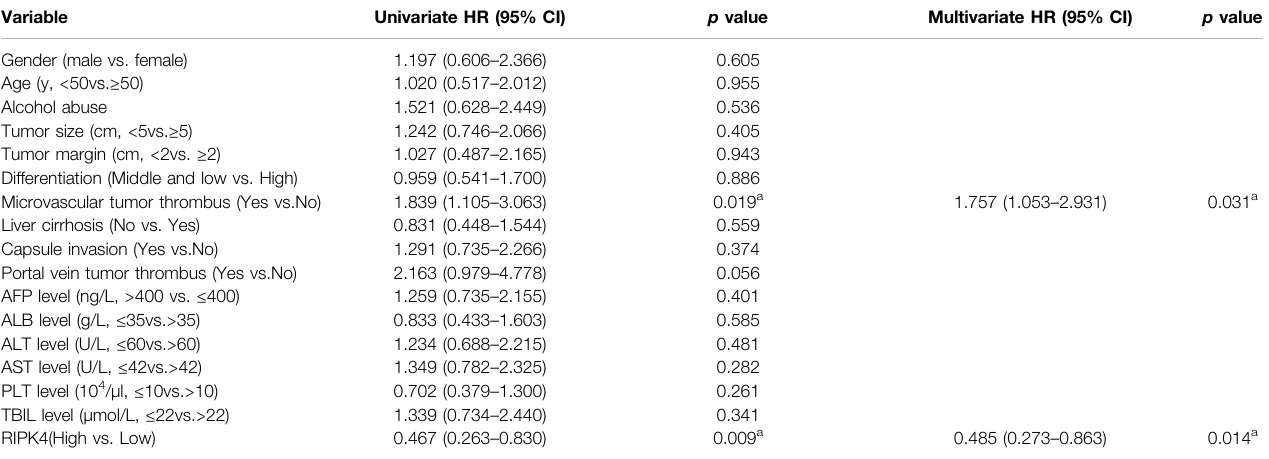
TABLE 2 | Univariate and Multivariate analysis of variables with overall survival.